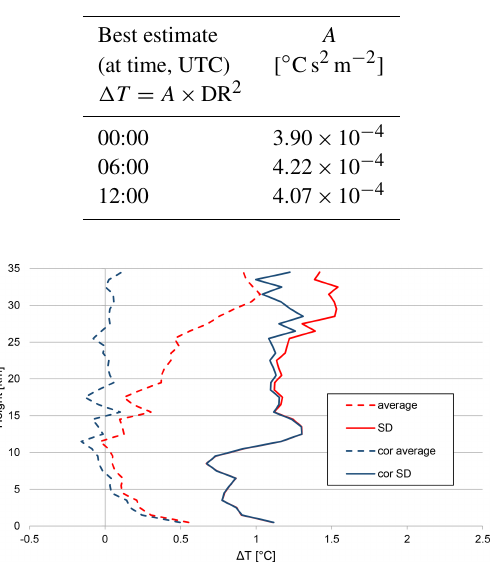
Figure 18. Average (cid:49)T and its standard deviation (SD) before and after friction correction (Praha-Libus).